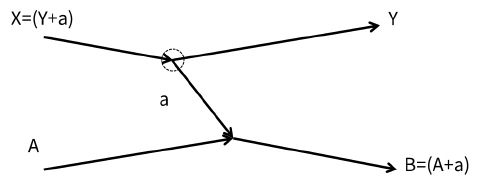
Figure 1. Sketch of a typical transfer